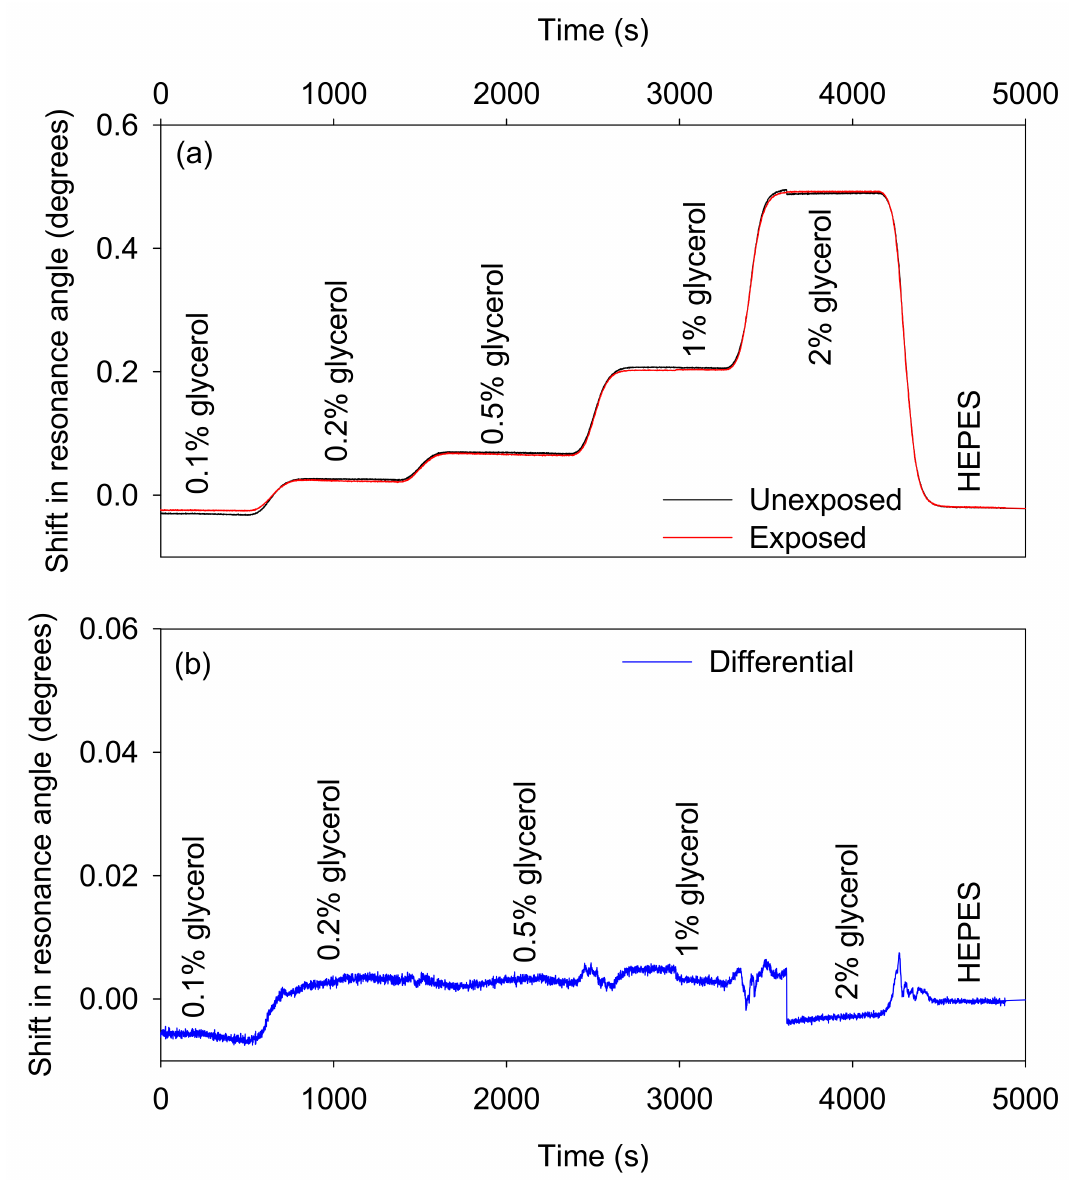
Figure 7. ( a ) Absolute and ( b ) di ff erential shifts in the resonance angles of the self-referenced di ff raction-based LW to changes in sample composition caused by di ff erent concentrations of glycerol